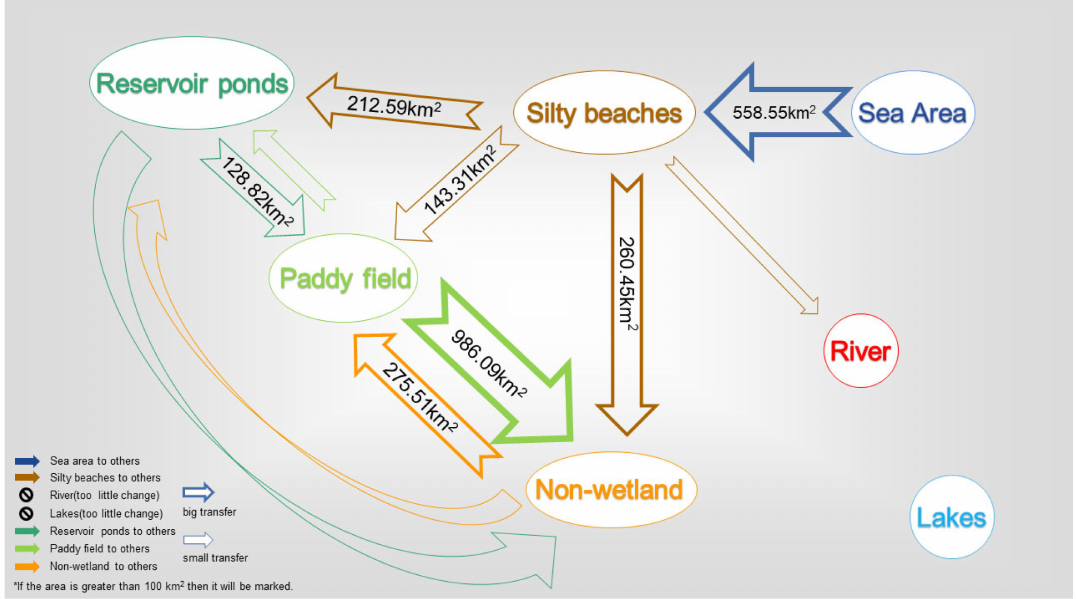
Figure 3. The main processes of surface-based transfer of wetland types in Hangzhou Bay during 30